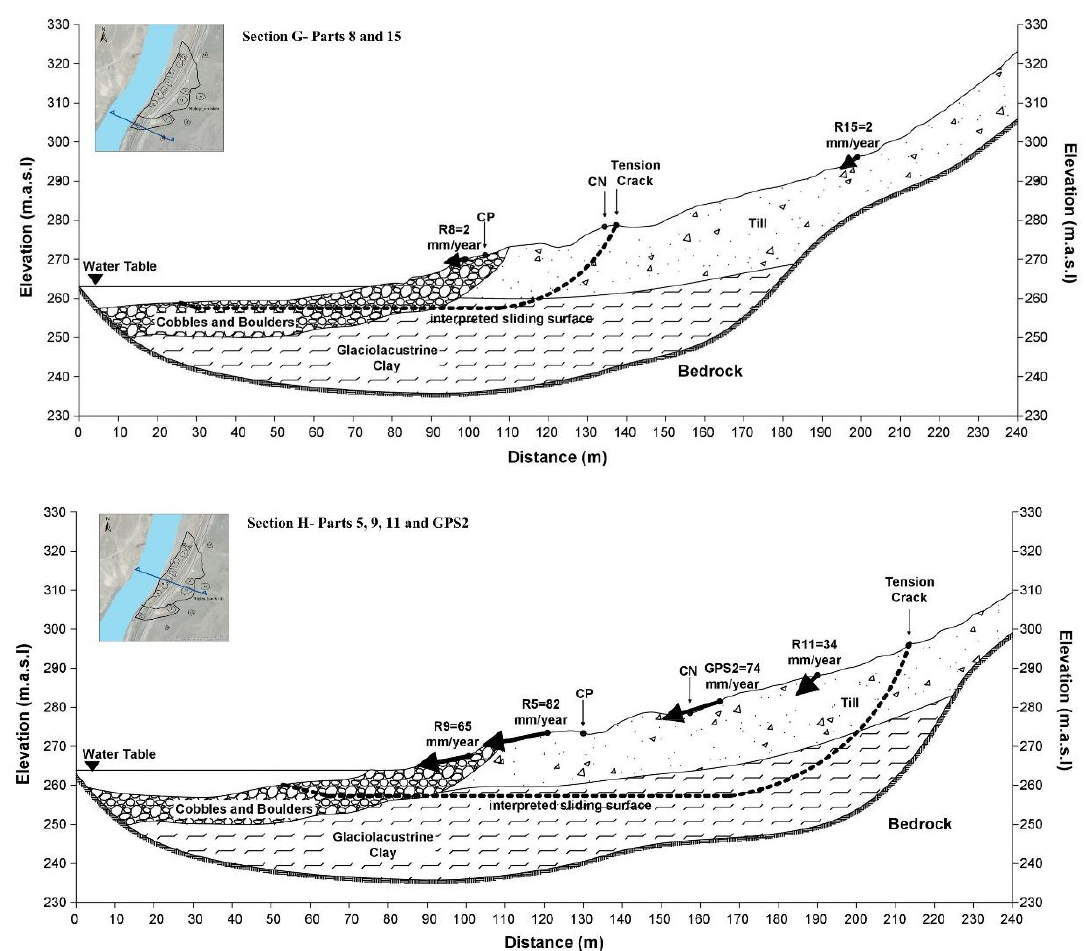
Figure 9. Real vectors (ground movement) in section view on Ripley landslide (sliding surfaces are drawn based on the position of tension tracks and interpreted shear surface by Hendry et al. [14] based on previous BH and SAA installation). Table 3. Magnitudes of R and direction.